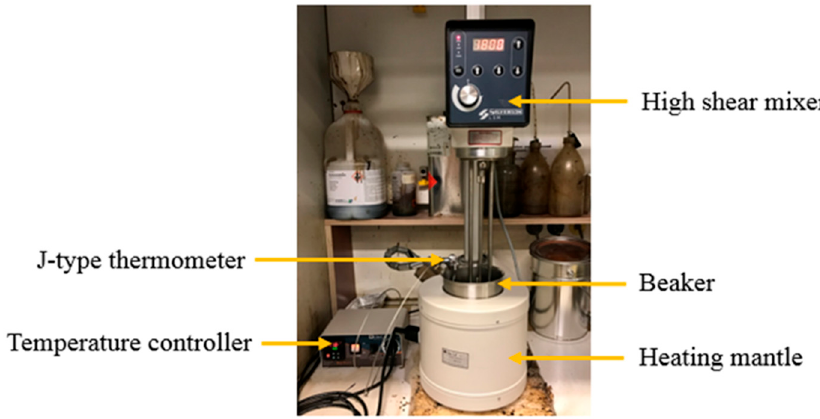
Figure 2. Laboratory equipment used to prepare crumb rubber-modified bitumen (CRMB).